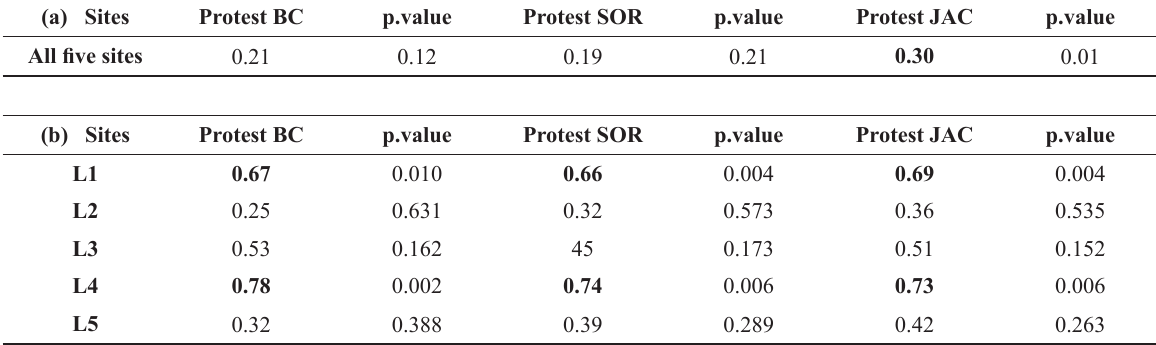
Concordance between sampling strategies (sub-surface/bucket and vertical haul). Concordance was performed using PCoA followed by Procrustes rotation and Protest significance test with 1000 permutations (BC: Bray Curtis index, SOR: Sorensen index, JAC: Jaccard index). Significant relationships (p < 0.5) in bold (a). Concordance performed per point between sampling strategies (sub-surface/bucket and vertical haul). Significant relationships (p < 0.5) in bold